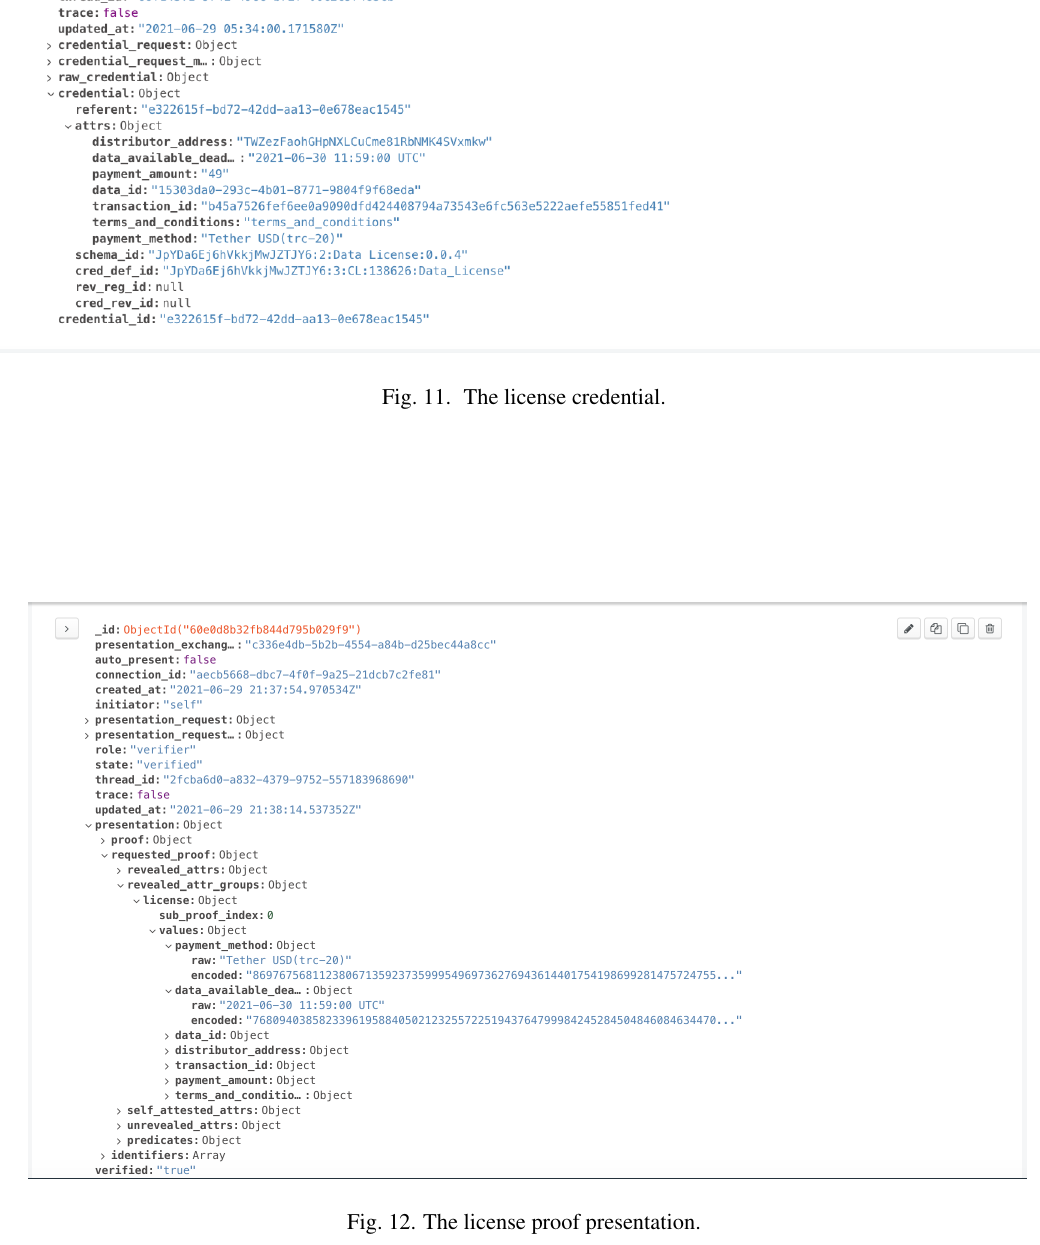
Fig. 12. The license proof